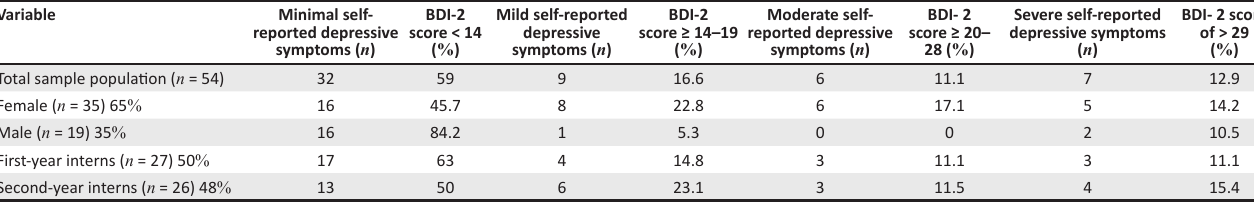
TABLE 1: Demographic characteristics and associated Beck Depression Inventory 2 scores.